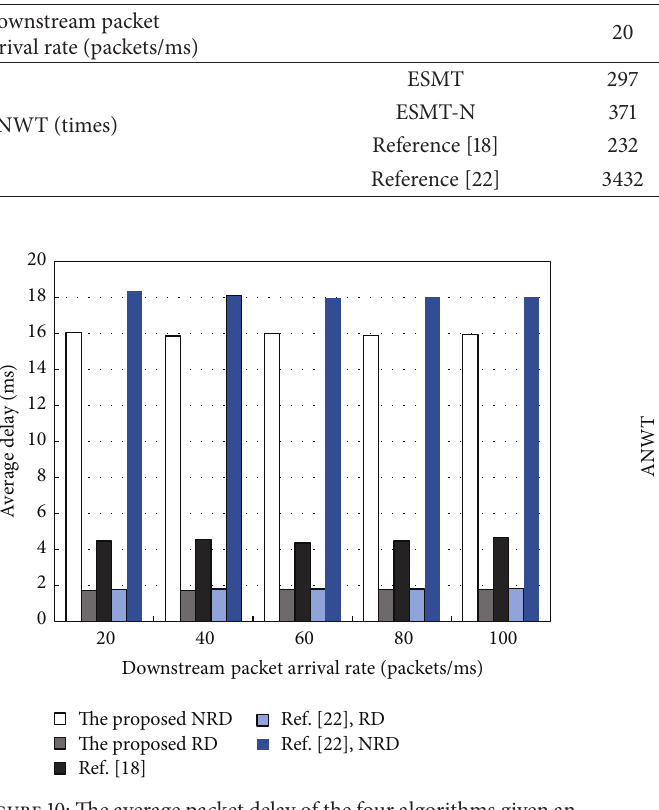
Figure 11: Comparison of ANWT under the two